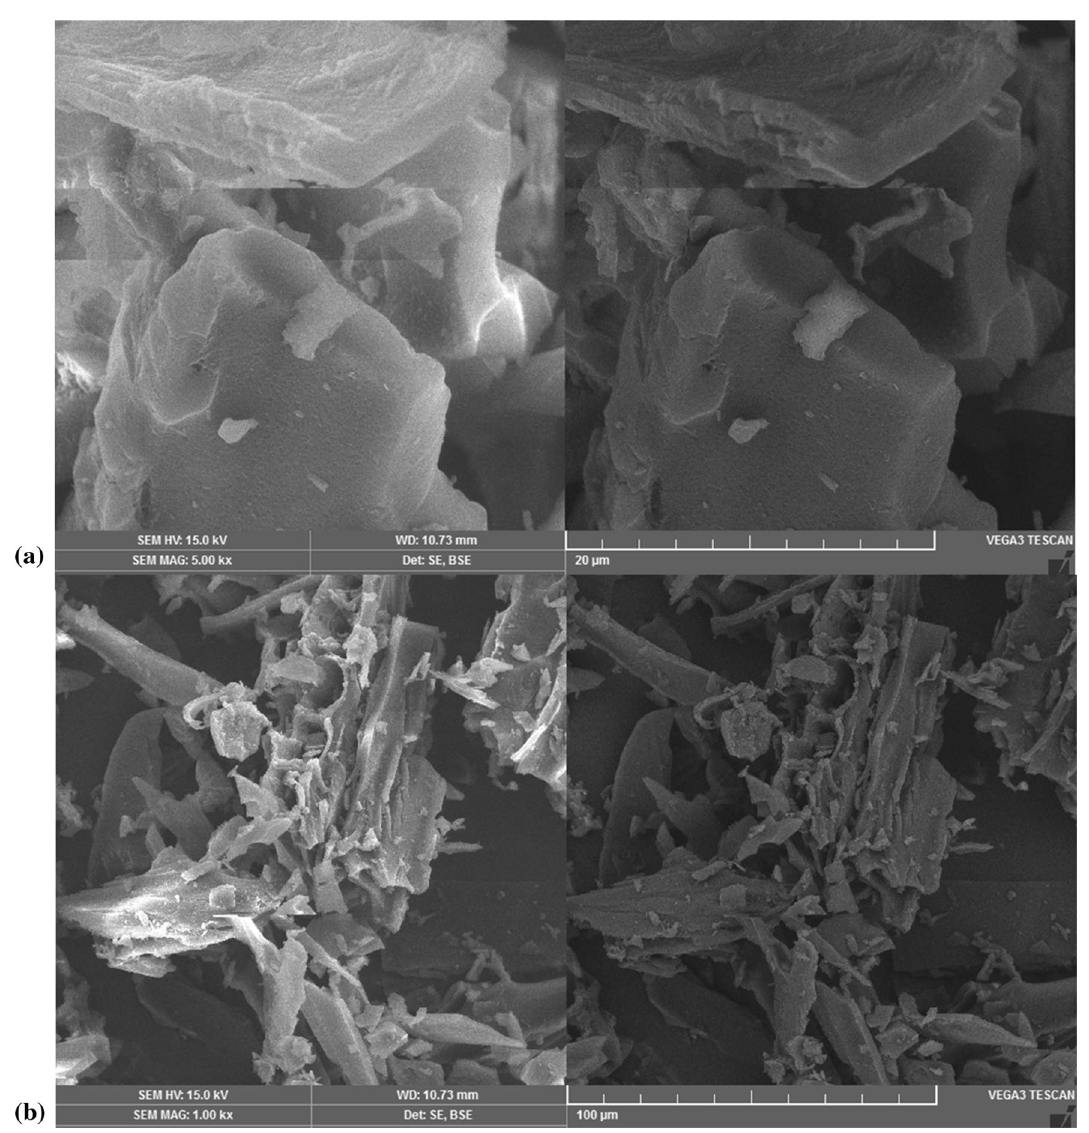
Fig. 3 SEM image of Fe-KWC showing smooth doping of iron nanoparticles on to KWC porous structure at resolutions of a 10 µm and b 100